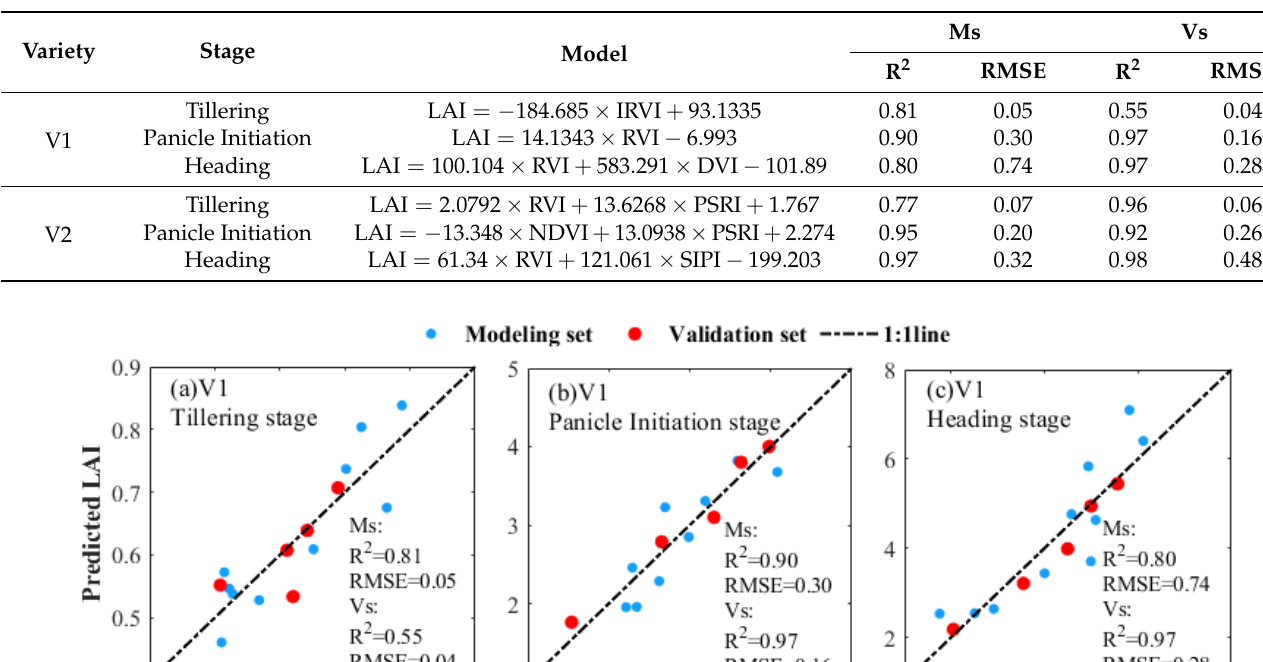
Table 4. Leaf area index (LAI) regression models and their accuracy for rice varieties V1 (Meixi- angzhan 2) and V2 (Wufengyou 615) at different growth stages.